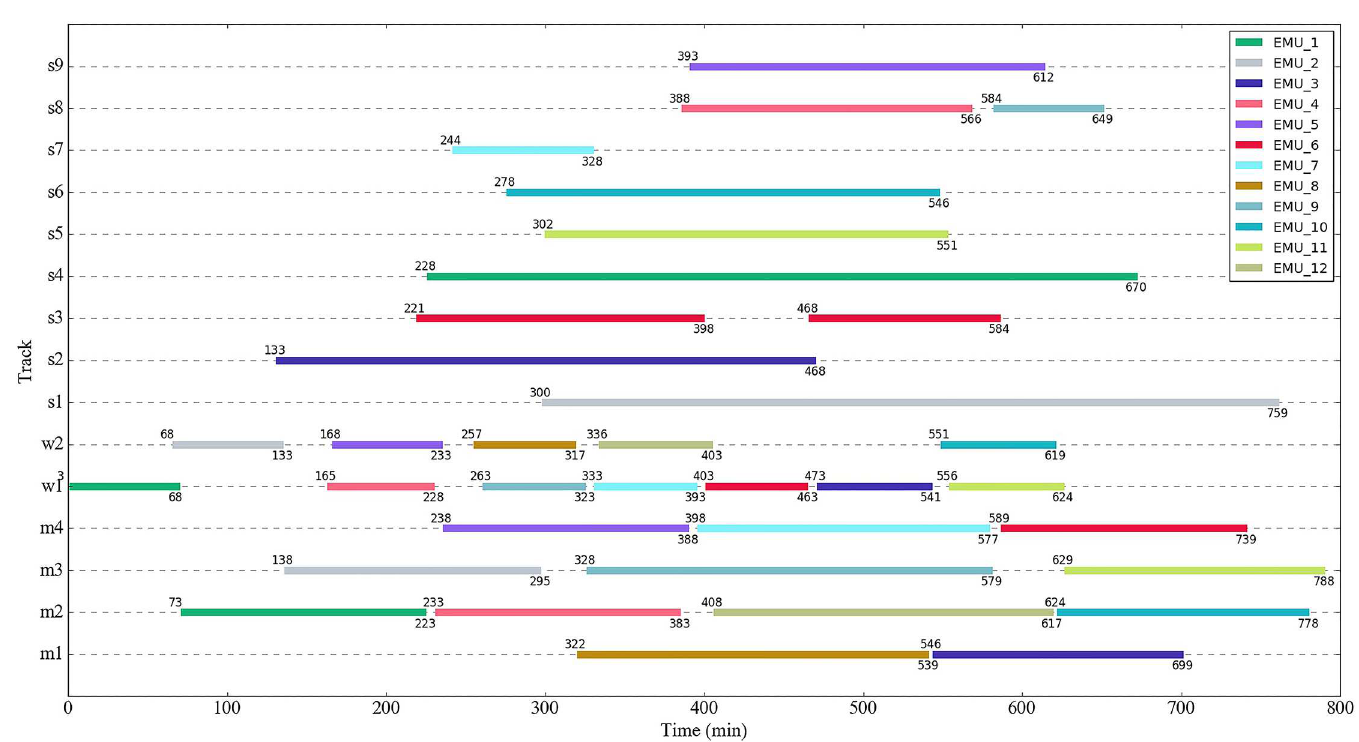
Fig 3. Diagram of the depot shunting schedule.